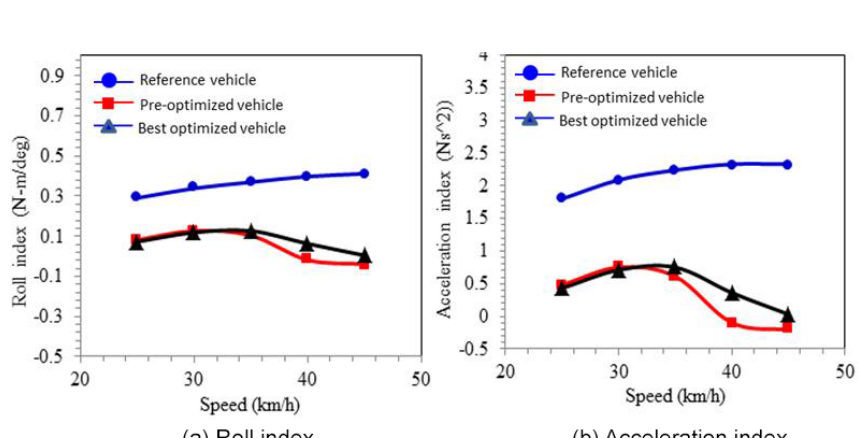
Figure 20. The evaluation index of the steady circle.